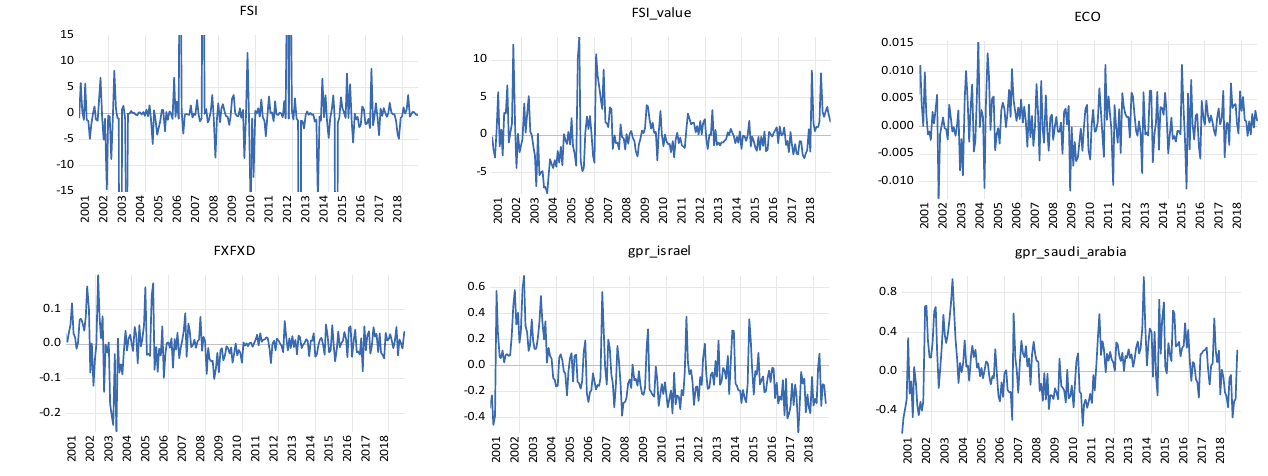
Figure 1. Growth pattern of variables.